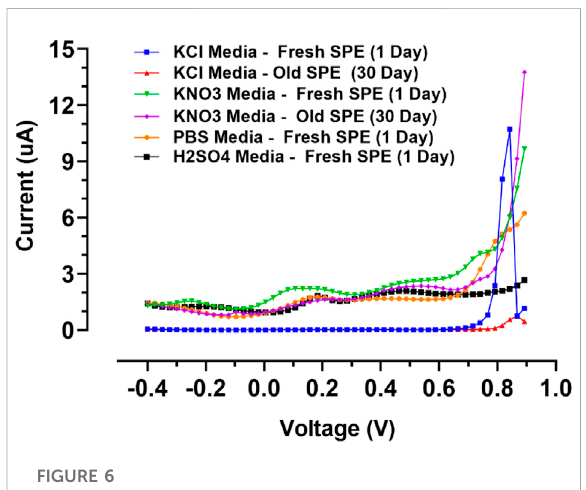
FIGURE 6 Differential pulse voltammograms of fresh and old SPEs in selected supporting electrodes.